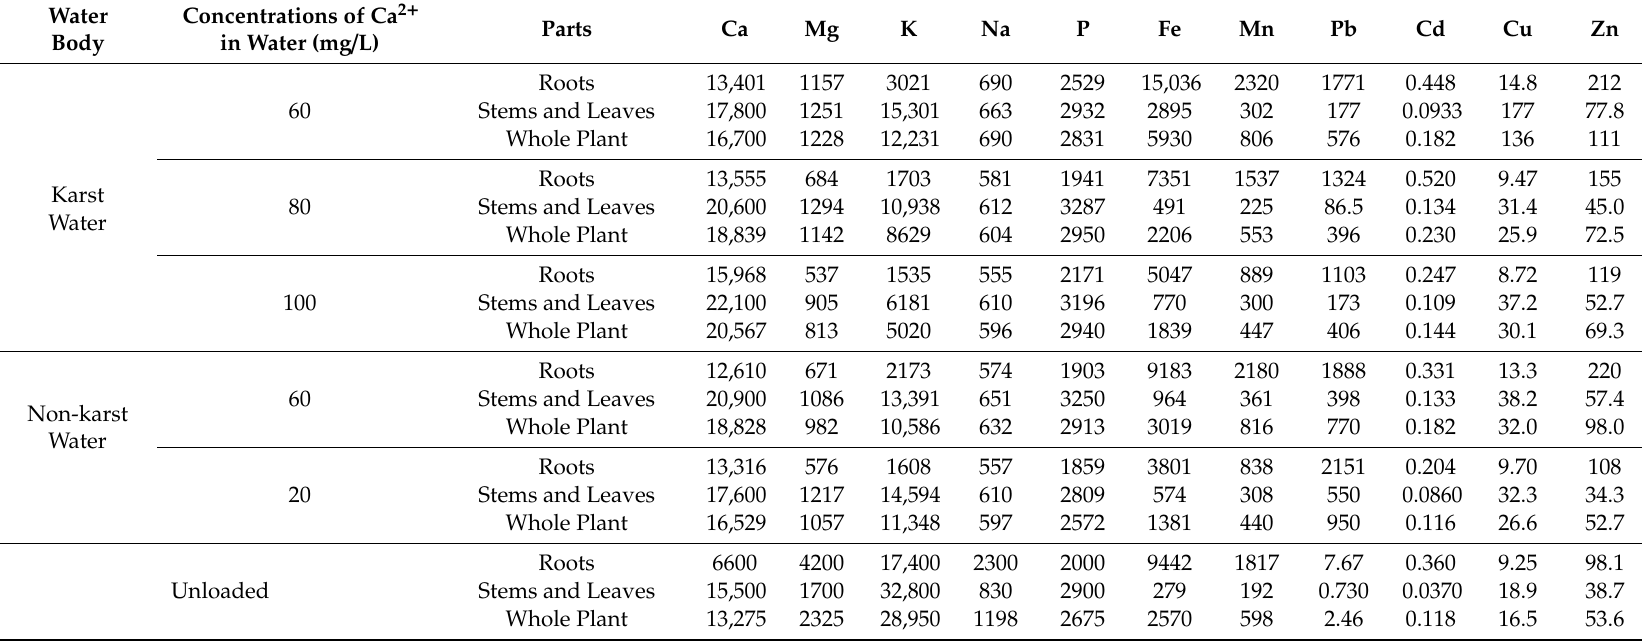
Table 3. Elemental composition of di ff erent E. crassipes structures before and after Pb absorption in water with di ff erent Ca 2 + concentrations (mg / kg). Water Concentrations of Ca 2 + Body